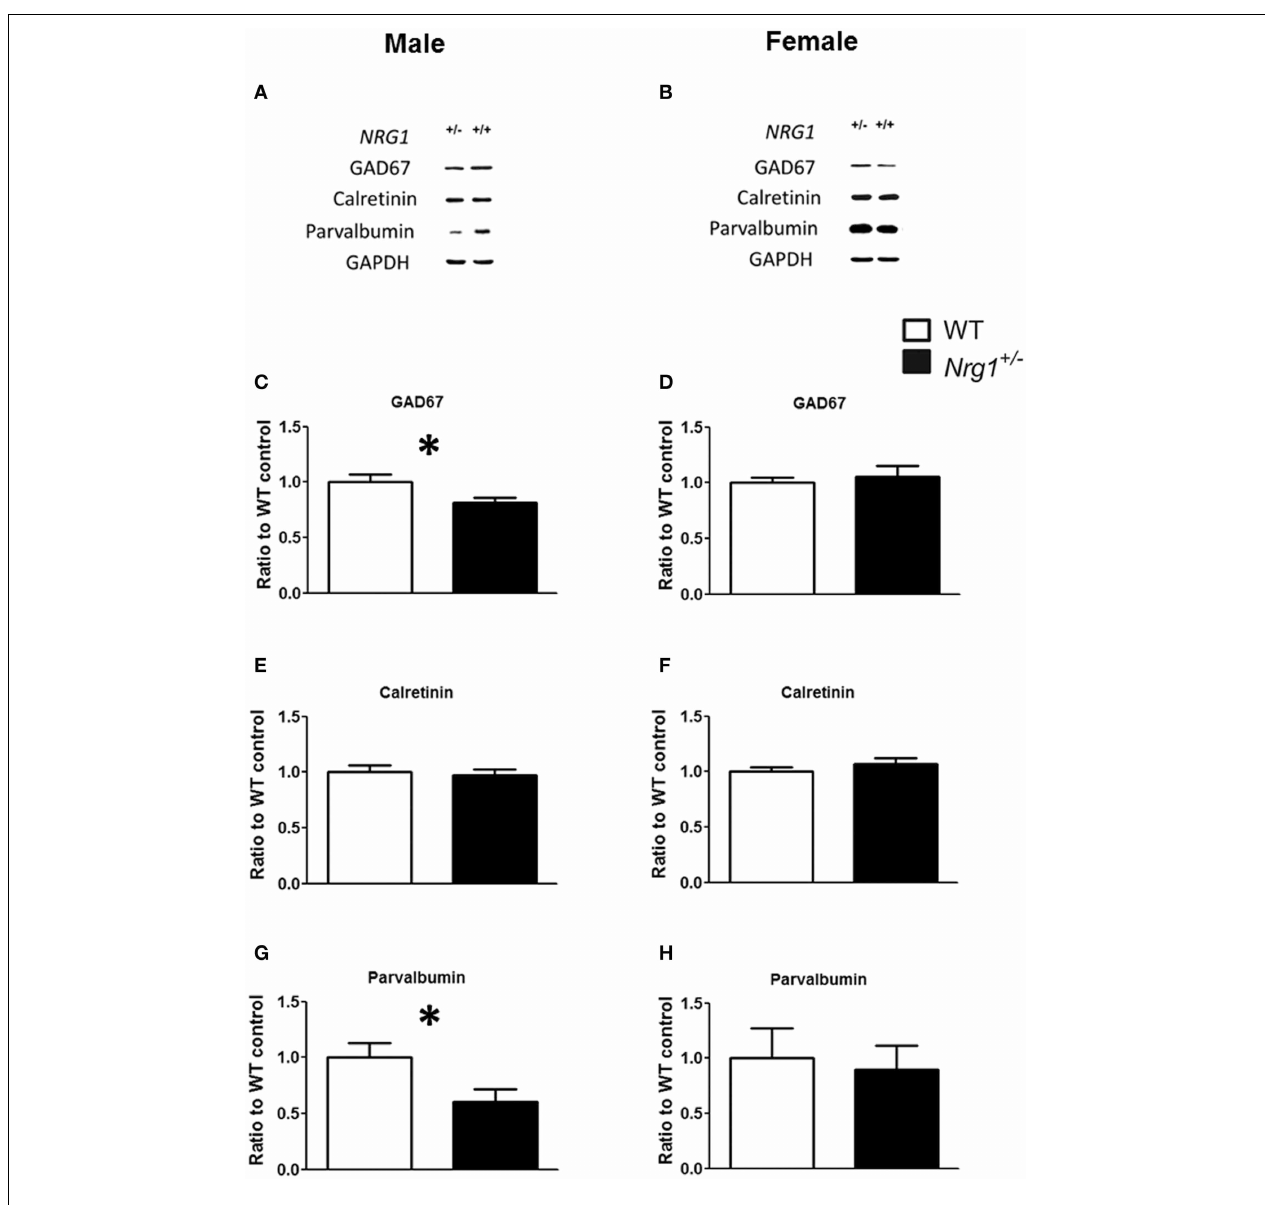
FIGURE 4 | The neurochemical analysis of the expression of GABAergic markers in the hippocampi of the novel TMc- Nrg1 + / − mutant mice (black bars) and their wild-type controls (WT, white bars) determined by Western blot. (A,B) Representative Western blots of hippocampal tissue (30 μ g/lane) with GAD67 (67kDa), calretinin (29kDa), parvalbumin